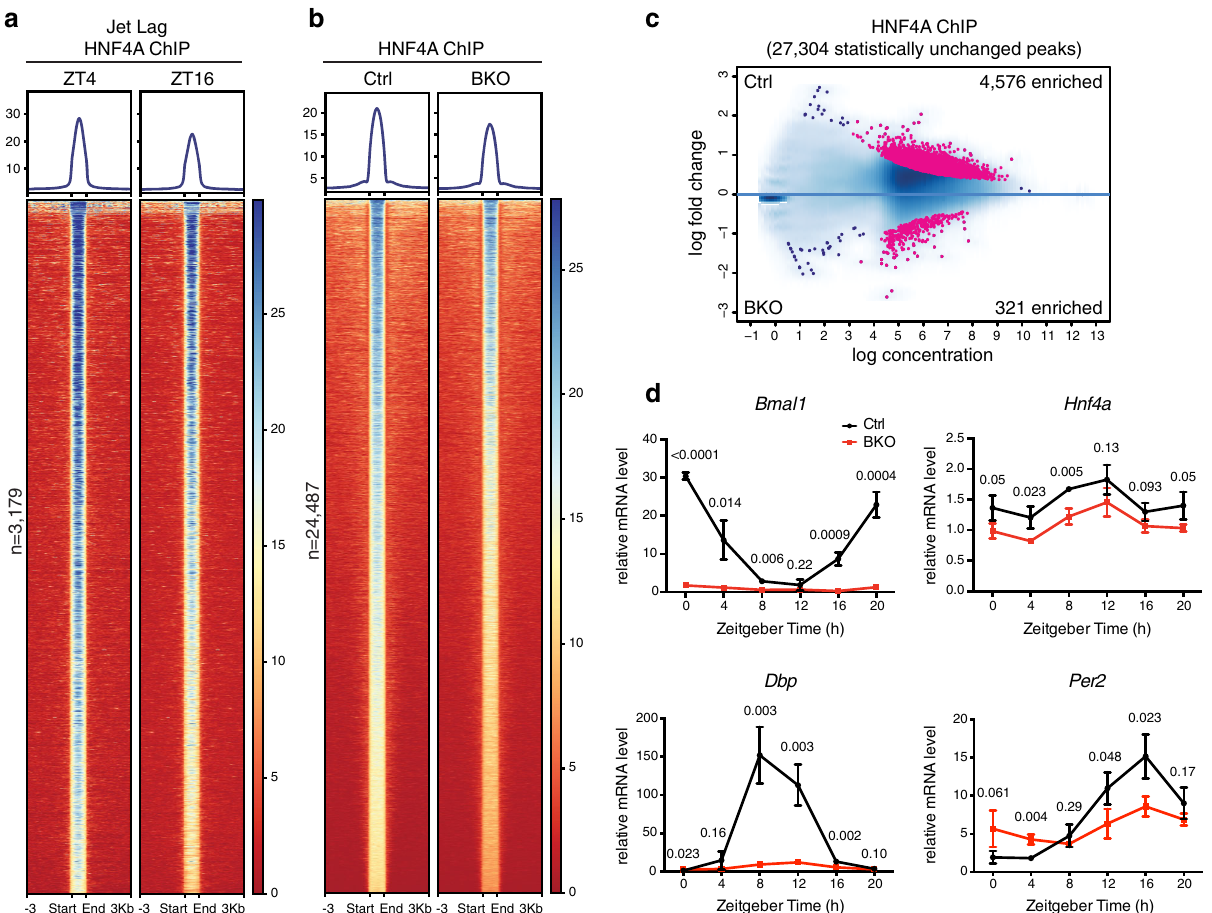
Fig. 6 The circadian clock modulates genome-wide DNA binding of HNF4A. a Heatmap of HNF4A ChIP-seq signals within liver tissues sampled at ZT4 (left) or ZT16 (right) after jet lag treatment and centered at all HNF4A peaks of ZT4. Peaks are ordered vertically by signal strength. b Heatmap of HNF4A ChIP-seq signals at ZT16 in control (left) or BKO (right) liver centered at all HNF4A peaks in control liver. Peaks are ordered vertically by signal strength. c MA plot showing differential HNF4A peaks in control and BKO livers, using a threshold of FDR < 0.05. The x -axis represents the mean number of reads (log scaled) within the peaks across all samples. The y -axis represents the log fold change between the two samples. d Control and BKO mouse livers were harvested at 4-h intervals over the course of 24 h. Transcript level of genes was analyzed by using RT-qPCR. Displayed are the means ± SD ( n = 3) normalized to non-oscillating Rplp0 expression levels. P -values determined by two-tailed Student ’ s t -test were